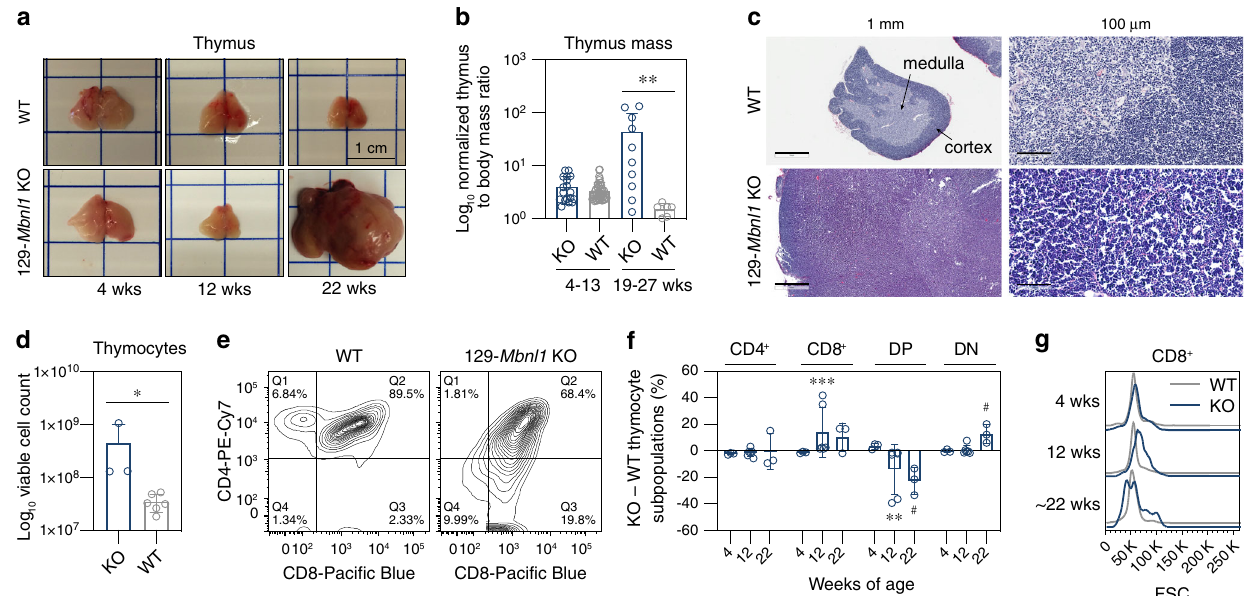
Fig. 2 Thymic hyperplasia in aged Mbnl1 KO mice. a Representative photos of male WT and 129- Mbnl1 KO thymi at 4, 12, and 22 weeks of age. The normal process of thymic involution that occurs in WT is disrupted in 129- Mbnl1 KO at 22 weeks. b Male thymic wet weight normalized to body weight is signi fi cantly increased in 129- Mbnl1 KO ( n = 10) compared to WT ( n = 6) at 19 – 27 weeks. There is no signi fi cant difference between 4 and 13 weeks (WT = 50, KO = 18). Bar graph shows mean ± SD. Signi fi cant difference was determined by the Mann-Whitney test: ** P = 0.003. c Hematoxylin and eosin (H&E) stain of WT and enlarged 129- Mbnl1 KO thymi. d Increased number of viable thymocytes in enlarged 129- Mbnl KO (n = 3) compared to WT (n = 6) thymi by ~22 (20± 2) weeks. Bar graph shows mean ± SD. Signi fi cant difference was determined by the Mann – Whitney test: * P = 0.024. e Representative fl ow cytometry analysis of CD4 and CD8 expression in ~22 weeks WT and 129- Mbnl1 KO thymocytes. f Thymocyte composition at 4 (WT = 3; KO = 3), 8 (WT = 8; KO = 6), and ~22 (WT = 4; KO = 3) weeks. CD4 + , CD8 + , CD4 + CD8 + double positive (DP) and CD4 - CD8 - double negative (DN) thymocytes were analyzed by fl ow cytometry. Graph represents mean KO – WT subpopulations ± SD. Signi fi cant difference was determined by the Mann – Whitney test: # P = 0.057, ** P = 0.007, *** P = 0 .0007. g Representative fl ow cytometry Forward Scatter (FSC) parameter plots showing different relative